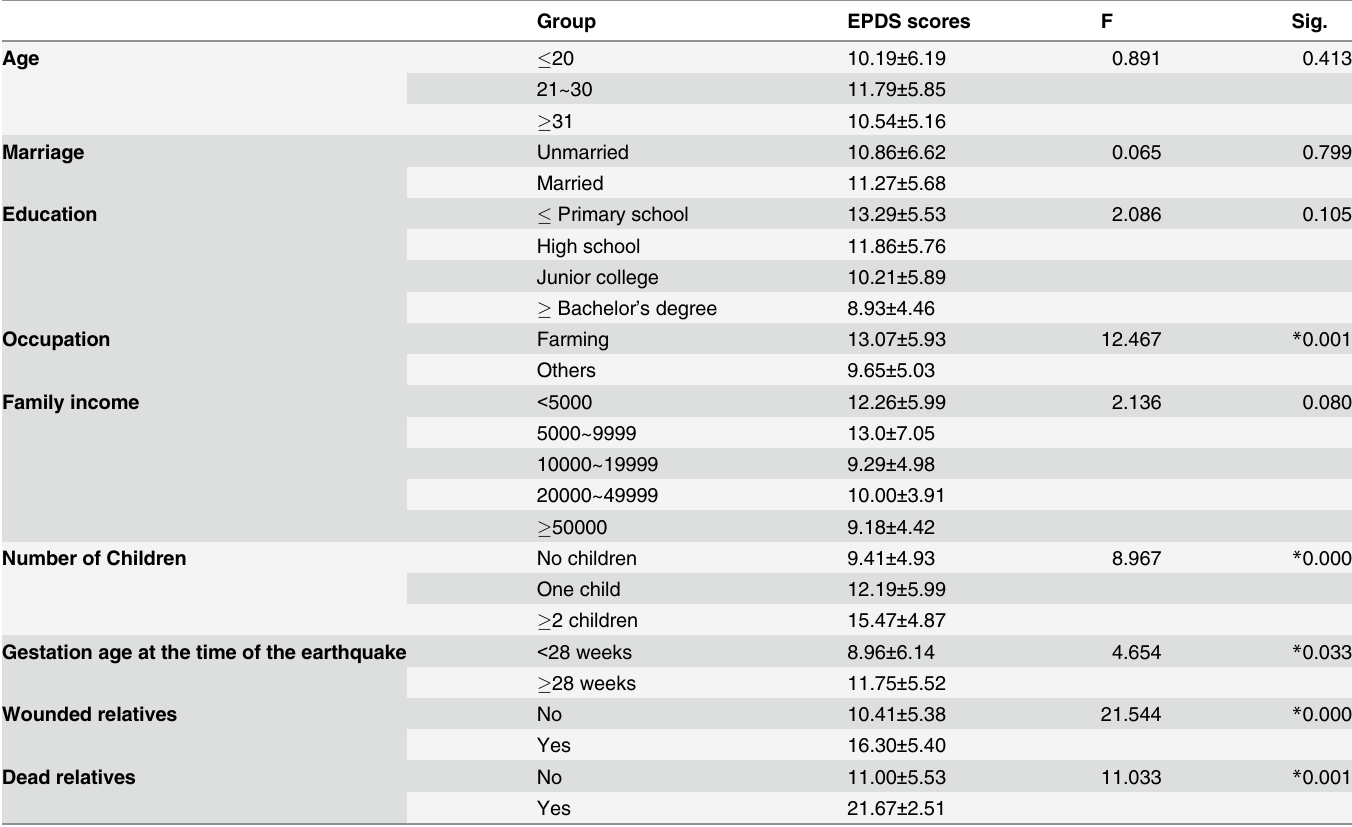
Table 3. ANOVA of EPDS scores against demographic